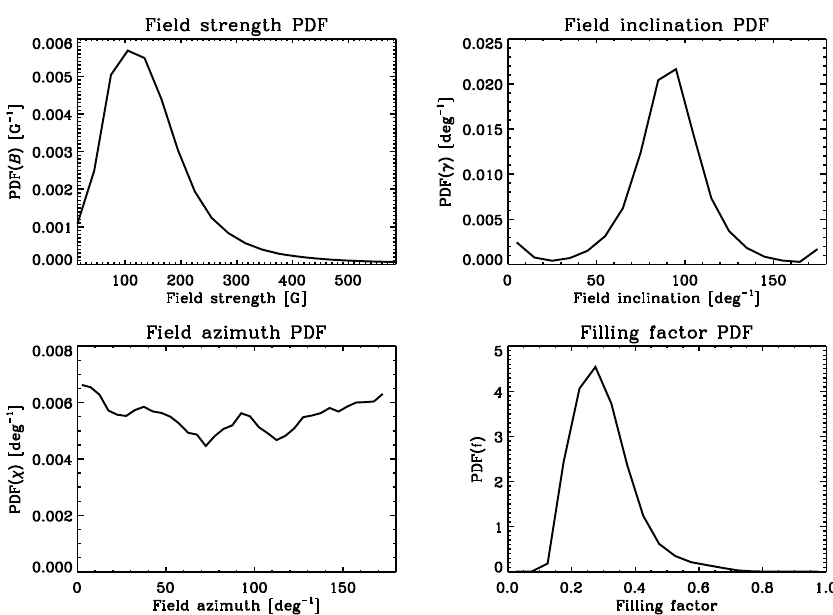
Fig.35 Distribution of field strengths, field inclinations, field azimuths and, filling factor in a typical Hanle resolution element of size 0 . 5 (cid:2)(cid:2) × 5 (cid:2)(cid:2) after integrating for 5 min. The distributions have been derived from real Hinode/SP observations with a pixel size of 0 . 16 (cid:2)(cid:2) × 0 . 16 (cid:2)(cid:2) and a noise level of 3 × 10 − 4 I